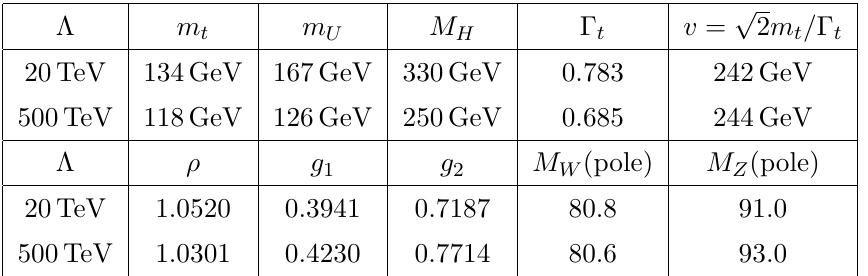
p 2 m t = (cid:0) t is